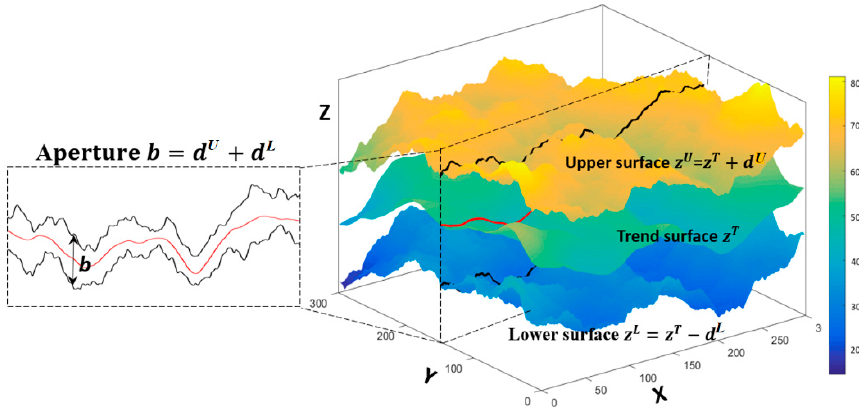
Figure 3. A fracture model of 300 × 300 × 100 voxels with a trend surface surrounded by two fracture wall surfaces, where the three surfaces are generated in the same means with five pre-defined parameters: µ b = 10 voxels, σ b 2 = 10, λ b = 20 voxels, σ T 2 = 90, and λ T = 120 voxels.